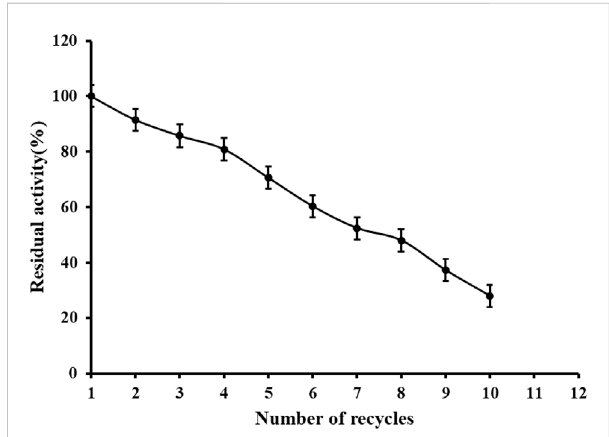
FIGURE 9 Reusability of immobilized re Sc NRK1. According to the above enzyme activity measurement method, repeatedly measure the activity of immobilized